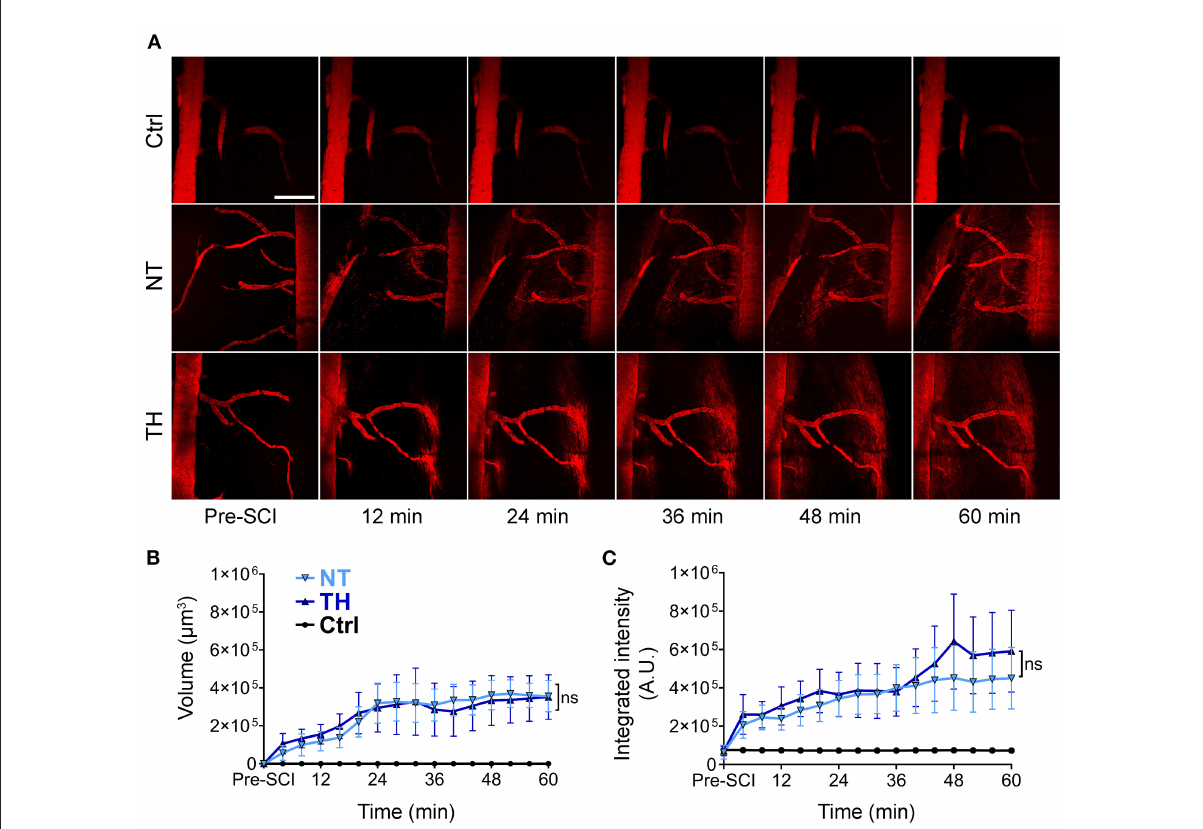
FIGURE1 BSCB leakage of intravenously injected fluorescence-dextran in the injured segment after SCI. (A) Representative images of in vivo two-photon microscopy of the intravenously injected 40 kDa TRITC-dextran leaking from the disrupted BSCB an hour post-SCI. The 40 kDa TRITC-dextran did not leak from the normal BSCB pre-SCI. Scale bar: 200 µ m. (B) The effect of TH on the volume of extravascular TRITC-dextran leaked from the disrupted BSCB an hour post-SCI ( P = 0.997). (C) The effect of TH on the integrated intensity of the extravascular TRITC-dextran leaked from the disrupted BSCB with TH an hour post-SCI ( P = 0.688). NT, normothermia; TH, therapeutic hypothermia; ns, non-significance. n = 6 mice per group, data are shown as mean ± SEM; nested, two-way ANOVA.